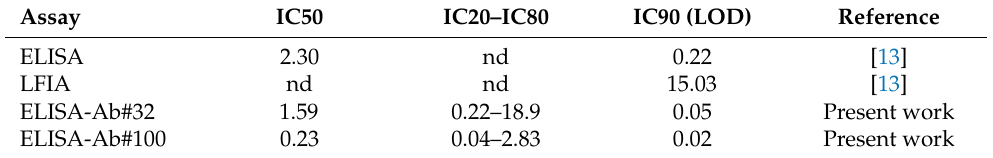
Table 3. Comparison of serum samples pretreatment approaches in recovery (RC) experiments.